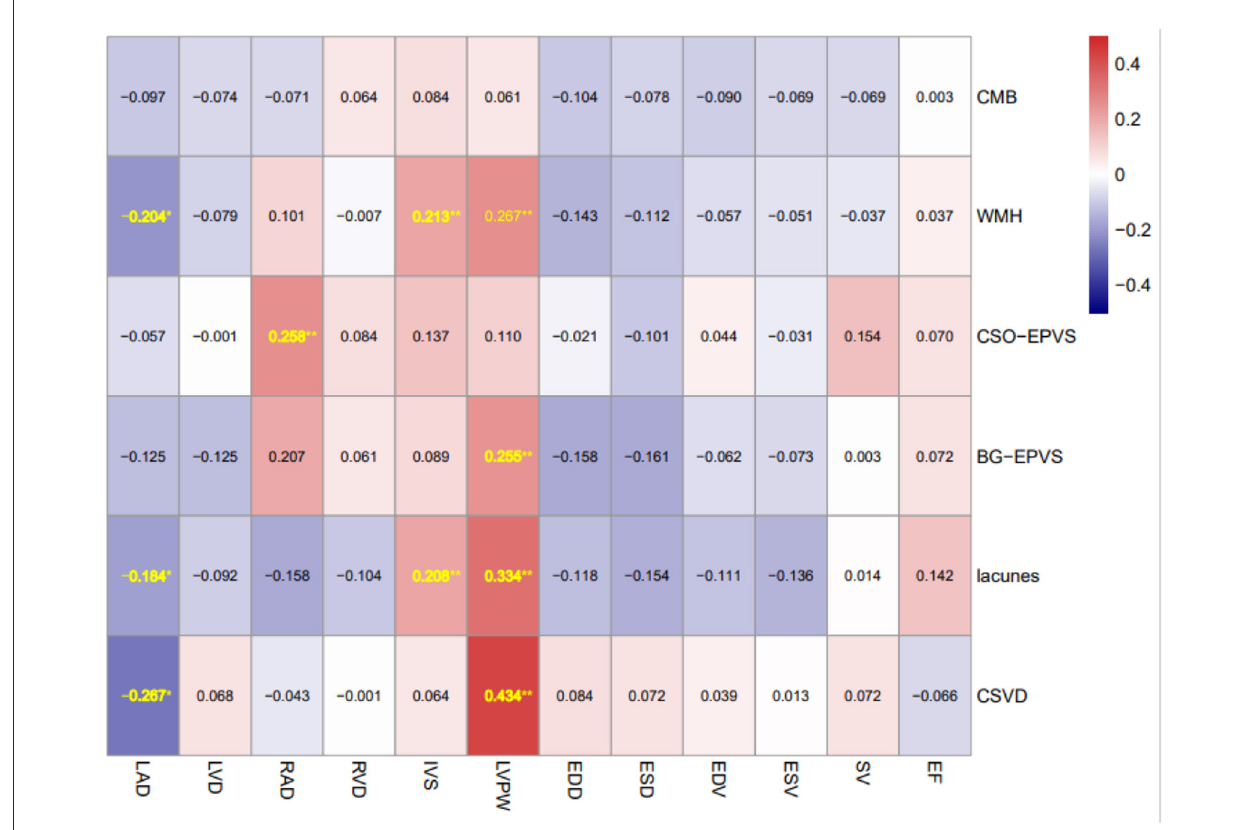
FIGURE2 Spearman correlation matrix of MRI markers of CSVD and echocardiographic parameters. Spearman correlation matrix of MRI markers of CSVD and echocardiographic parameters (number shown in the matrix is r coefficient with statistical significance) * P < 0.05 and ** P < 0.01. CSVD, cerebral small-vessel disease; WMH, white matter hyperintensities; CMBs, cerebellar microbleeds; BG-EPVS, enlarged perivascular spaces severity in basal ganglia; CSO-EPVS, enlarged perivascular spaces severity in centrum semiovale; LAD, left atrial anteroposterior diameter; LVD, left ventricular end-diastolic diameter; RAD, right atrial anteroposterior diameter; RVD, right ventricular end-diastolic diameter; IVS, interventricular septum diameter; LVPW, left ventricular posterior wall diameter; LVEDD, left ventricular end-diastolic diameter; LVESD, left ventricular end-systolic